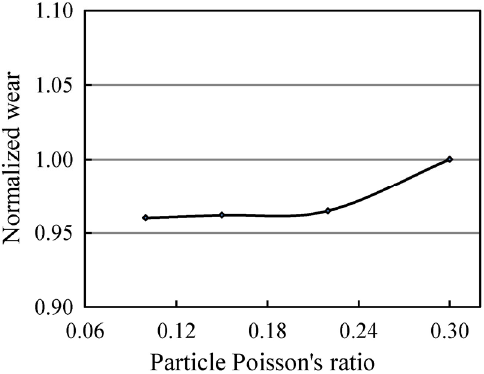
Fig. 10 Variations of the wear versus the particle Poisson’s ratio ( 10  ° and the other variables are at the reference